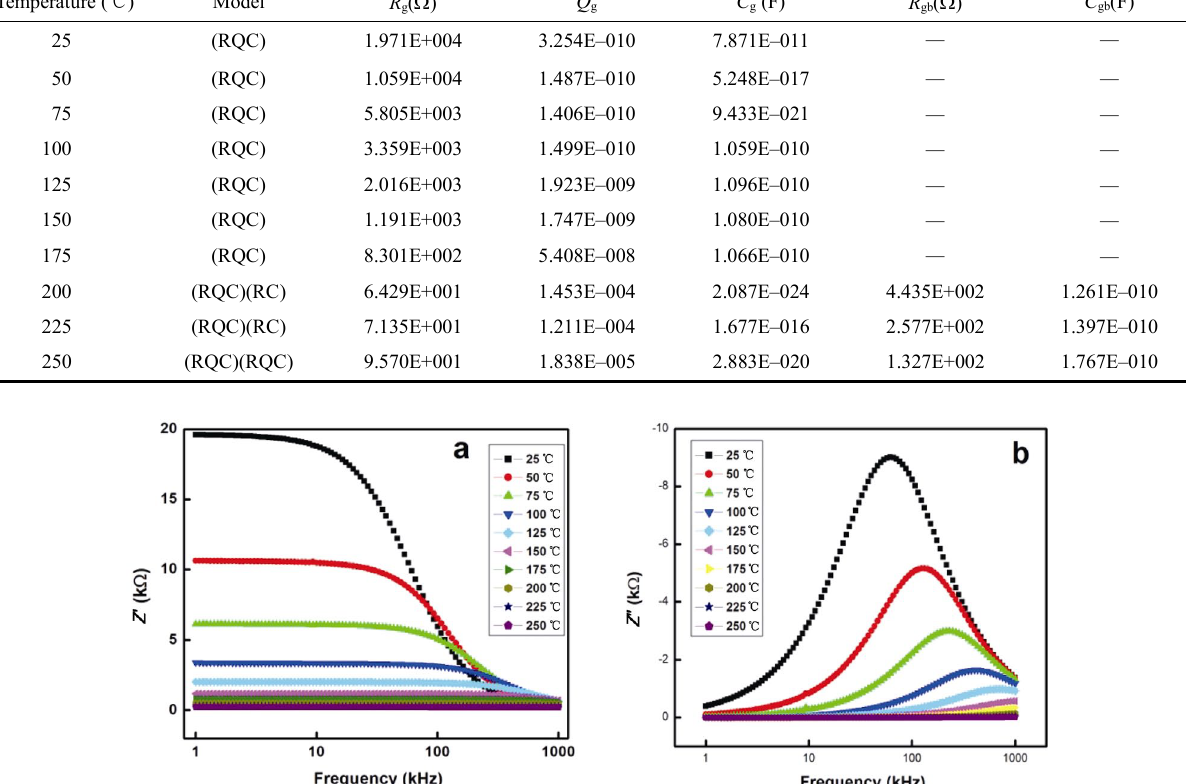
Fig. 5 Variations of (a) Z ′ and (b) Z ″ with frequency at selected